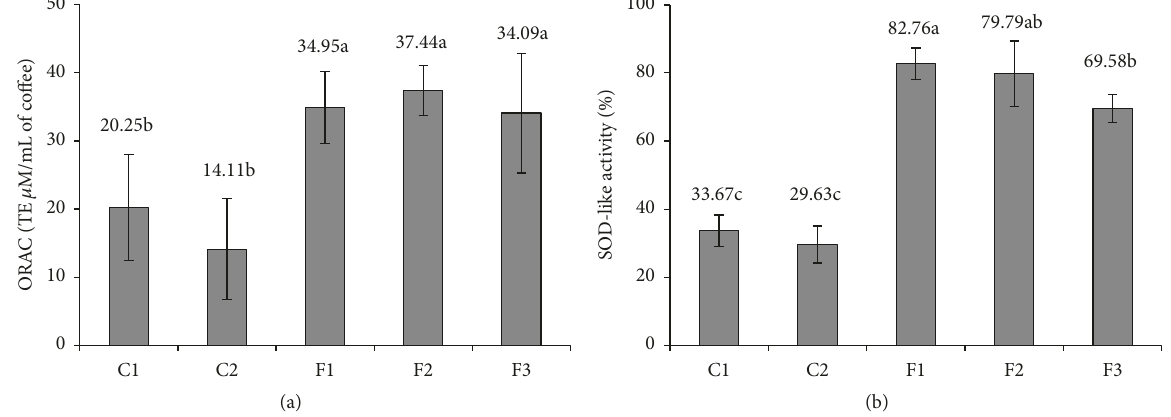
Figure 1: Antioxidant activities of yeast fermented coffee extracts by oxygen radical absorbance capacity (a) and superoxide dismutase-like (SOD-like) activity (b) assays. Different letters meant significant difference at P < 0.05 by Fisher’s least significant difference test.